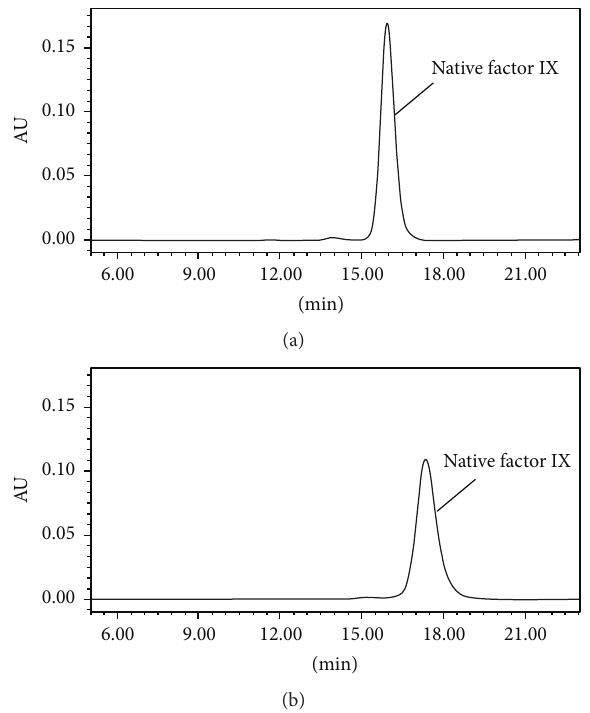
Figure 2: Gel filtration chromatography was performed using a TSK-Gel G3000SWXL column run at 22 ∘ C at a flow rate of 0.5 mL min −1 . The column was run in 50 mM Tris, 200 mM NaCl, and pH 7.5. 40 𝜇 g of total protein was loaded on the column per run. Absorbance at 280 nm is plotted against time in minutes. The upper tracing shows trenonacog alfa run in the absence of calcium. The lower tracing shows trenonacog alfa run in the presence of 5mM CaCl 2